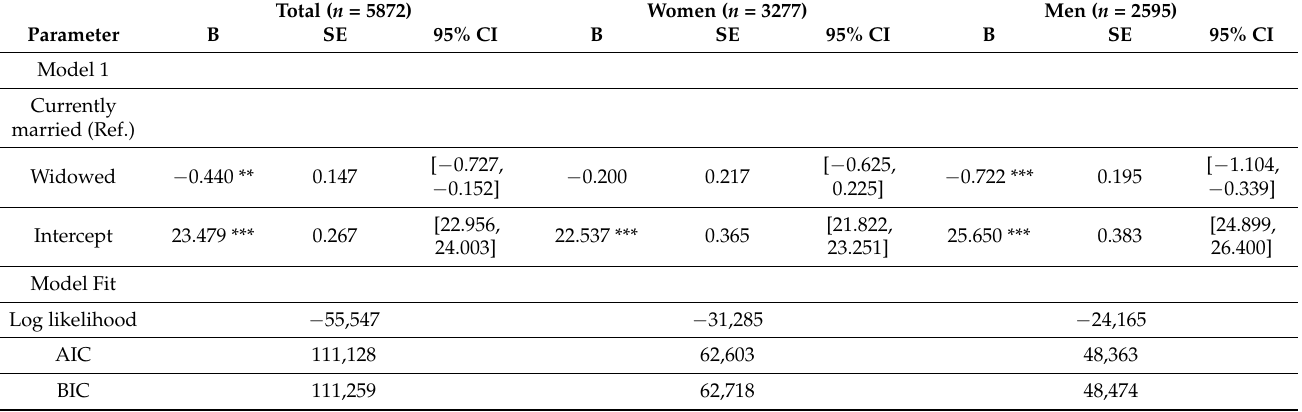
Table 3. The association between widowhood status and cognitive function. Total ( n = 5872) Women ( n = 3277) Men ( n = 2595)